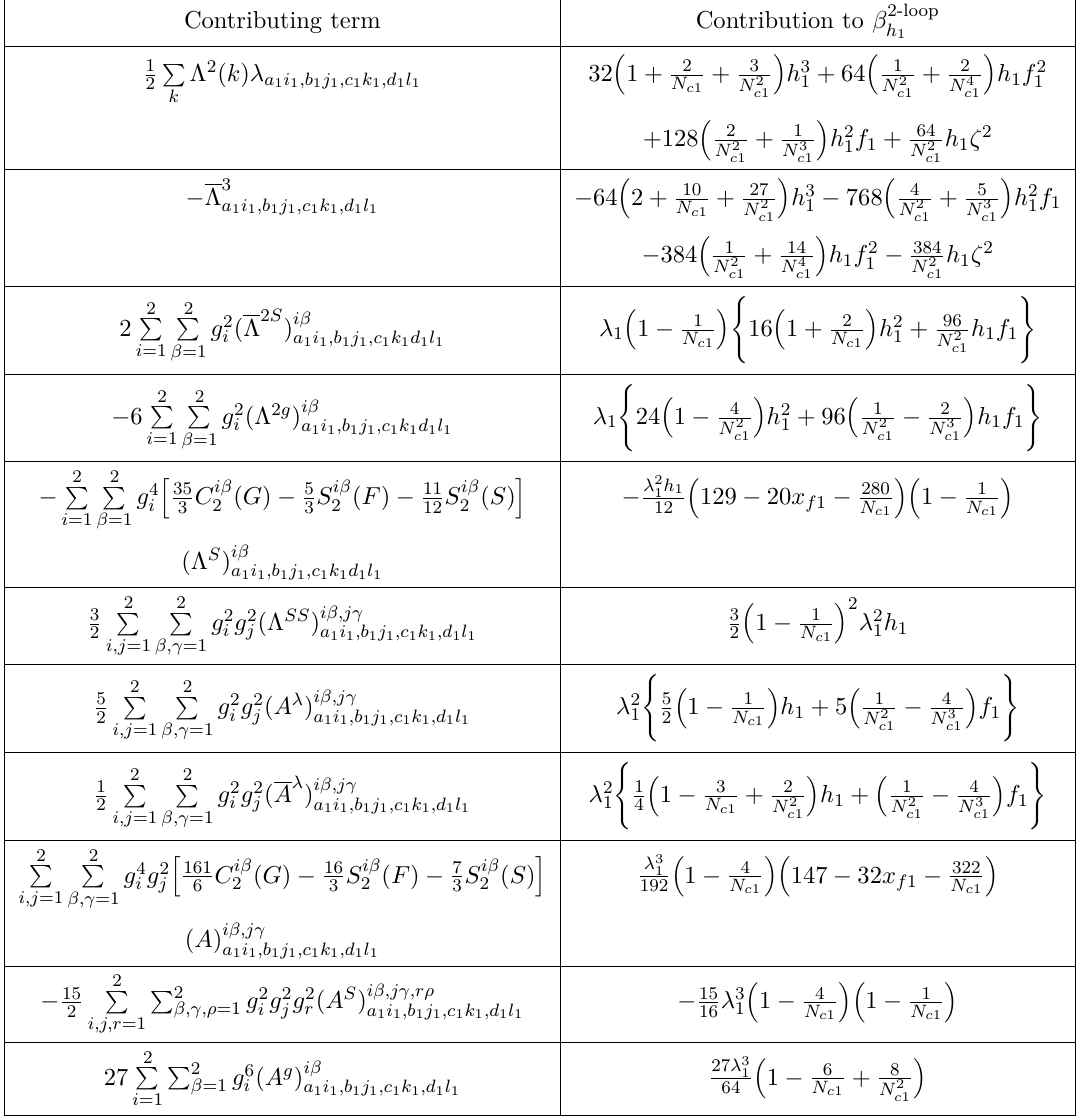
Table 3. Contribution of different terms to β 2-loop